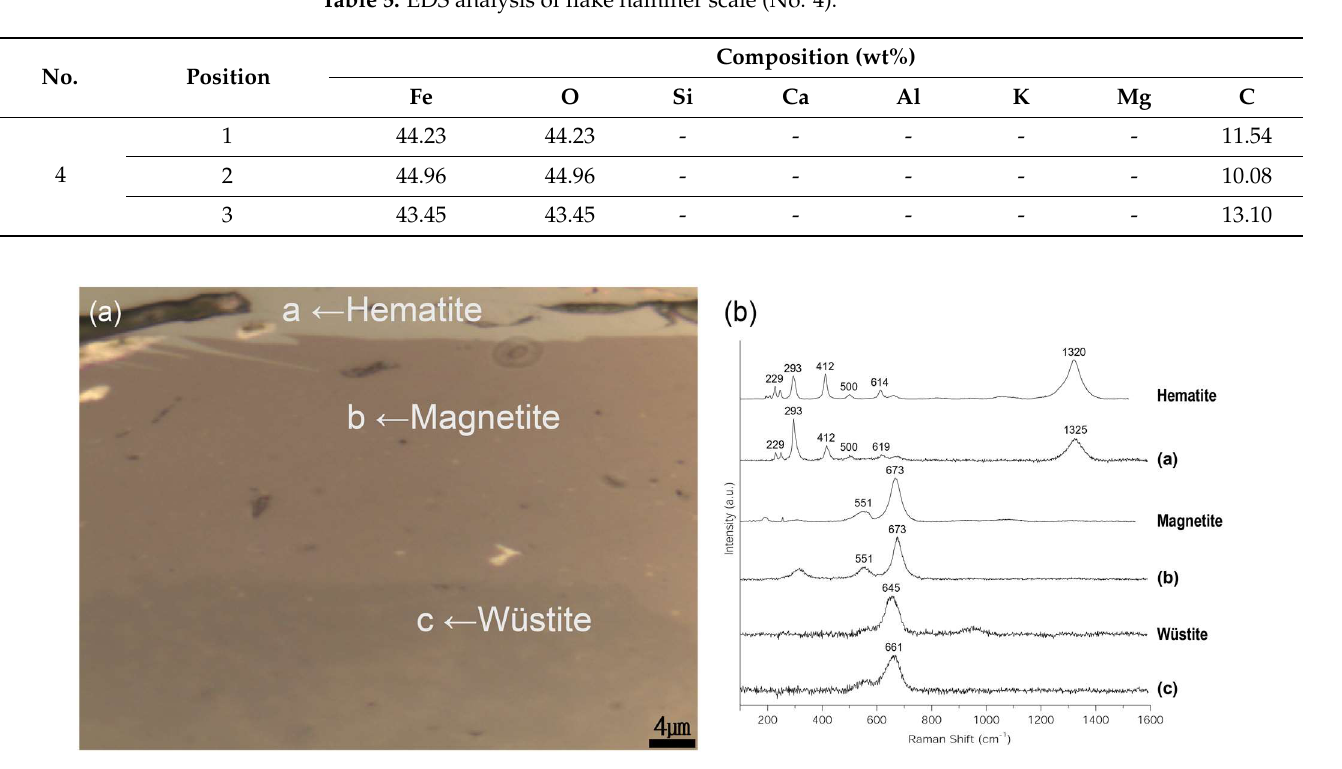
Figure 12. ( a ) Position of Raman micro-spectroscopy analysis of flake hammer scale (No. 4), ( b ) Ra- man spectrum. Table 5. EDS analysis of flake hammer scale (No. 4).